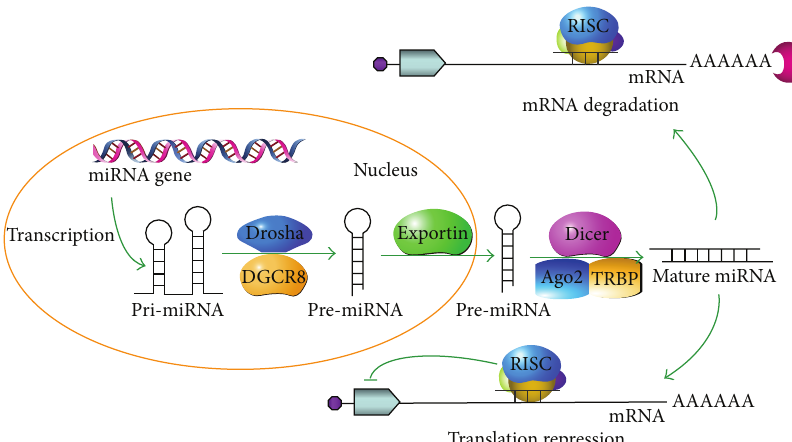
Figure 1: miRNA biogenesis. The miRNAs are transcribed by RNA polymerase II as primary transcript of miRNA (pri-miRNA). The pri- miRNA is the cleaved by RNase III enzyme, Drosha, along with several cofactors including DGCR8 and produces the stem-loop precursor miRNA (pre-miRNA). The pre-miRNA is then exported out of the nucleus by Exportin-5 to the cytoplasm. In the cytoplasm, the pre-miRNA is diced-up by Dicer resulting miRNA duplex, ∼ 22 nucleotides long. The mature miRNA is incorporated into the RNA-induced silencing complex (RISC) which contains Argonaute (Ago) and is guided to the 3 󸀠 -UTR of target mRNAs. The gene silencing is achieved by either mRNA degradation or translational